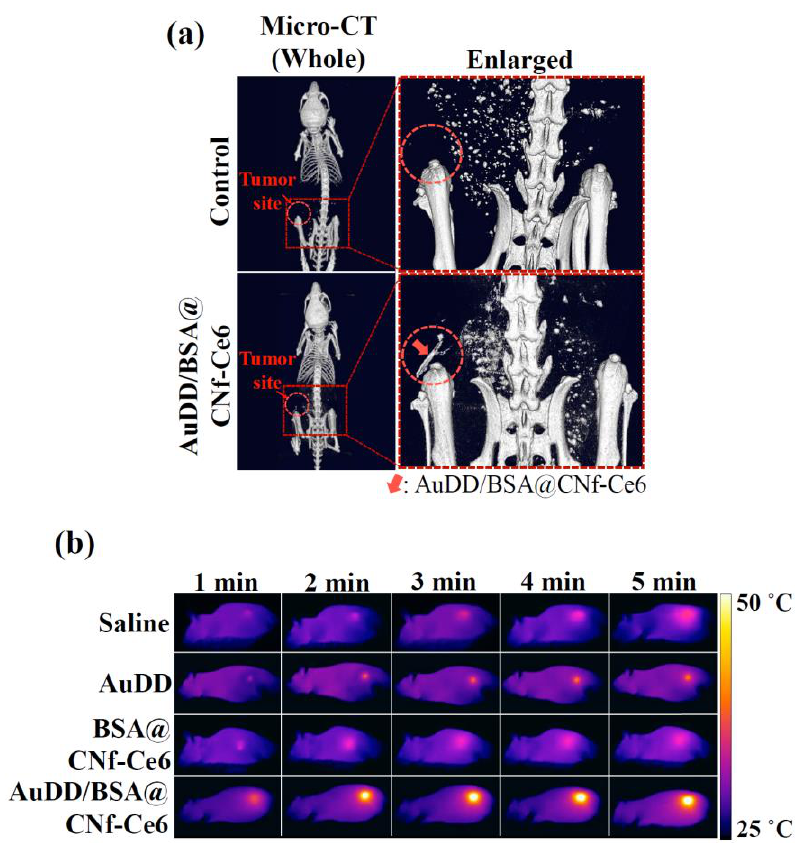
Figure 10. ( a ) In vivo micro-CT images of MDA-MB-231 tumor-bearing nude mice treated with saline (control) or AuDD/BSA@CNf-Ce6 at 8 h post-injection. The tumor sites are indicated by the dashed circles. ( b ) In vivo whole-body thermo-graphic images of the MDA-MB-231 tumor-bearing nude mice treated with saline (control), AuDD, BSA@CNf-Ce6, or AuDD/BSA@CNf-Ce6. The tumor sites were irradiated at a light intensity of 2 W/cm 2 using an 808 nm light source for 5 min after the 8 h administration.